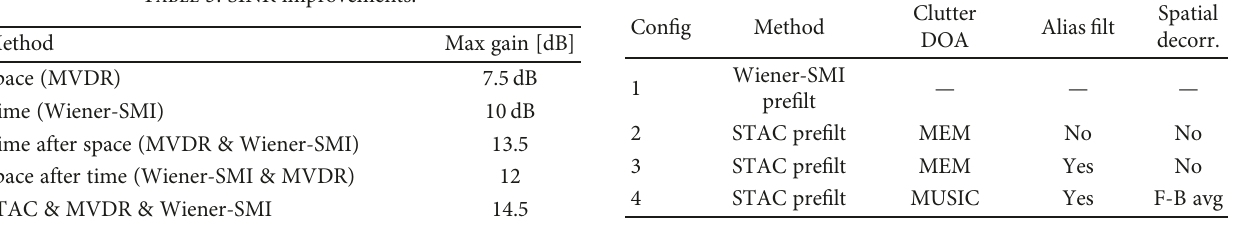
Figure 12: SINR improvements obtained from real measurements. (a) Improvements from the di ff erent domains (target number 1). (b) STAC improvement with di ff erent clutter DOA estimation techniques (target number 1). (c) STAC improvement with di ff erent clutter DOA estimation techniques (target number 2). Table 4: Algorithm con fi Table 3: SINR improvements.